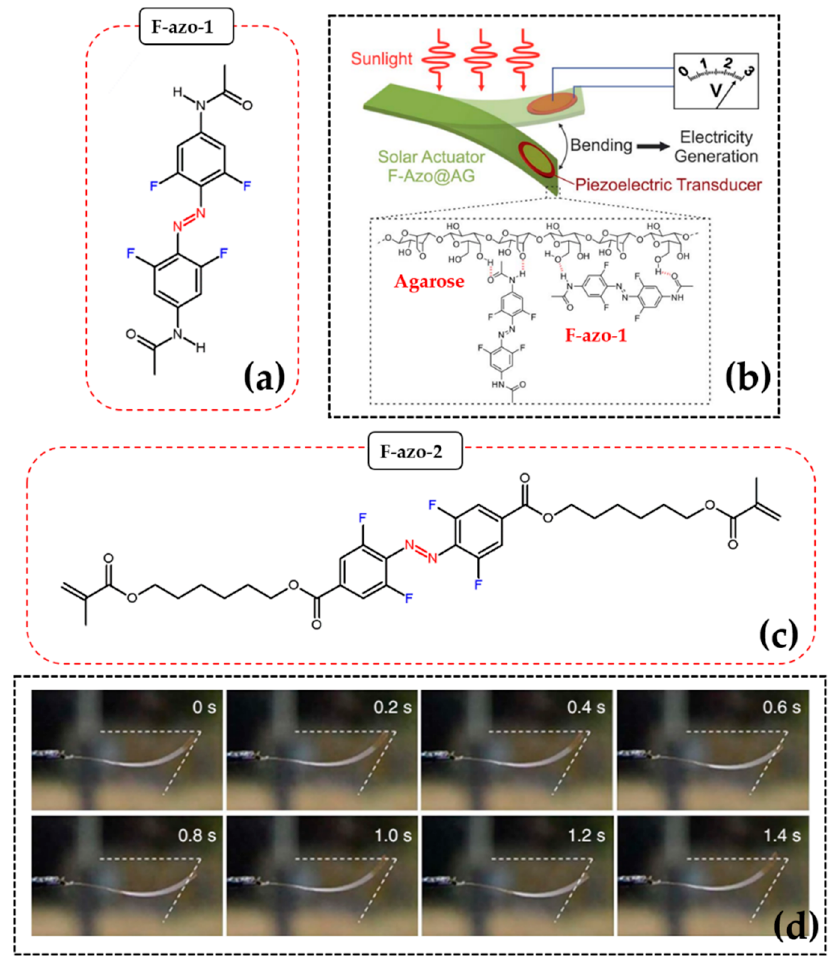
Figure 13. ( a – c ) Chemical structures of F-azo compounds, ( b ) Schematic illustration of the conversion of sunlight into electric power by combining a solar actuator made of supramolecular film (composed of F-azo-1, hydrogen bonded with agarose polymer matrix) with a piezoelectric transducer. The piezoelectric transducer is polyvinylidene difluoride (PVDF). The bending of the actuator under solar irradiation leads to bending of the piezoelectric transducer and subsequent generation of electricity. Adapted with permission from Reference [82], The Royal Society of Chemistry, 2018, ( d ) Series of photos portraying self-oscillatory motion of the liquid crystalline (LC) film (made of F-azo-2 and other LC monomers) during sunlight exposure. Adapted with permission from Reference [87], Springer Nature, 2016.